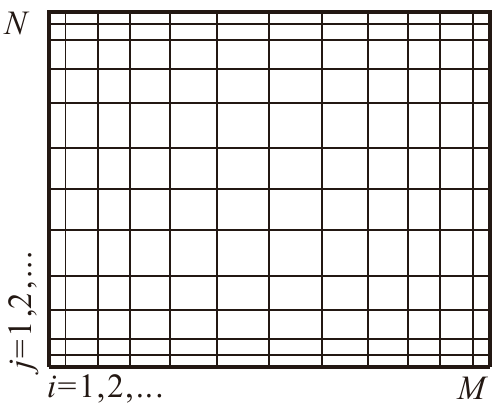
Figure 4. The distributions of grid nodes.